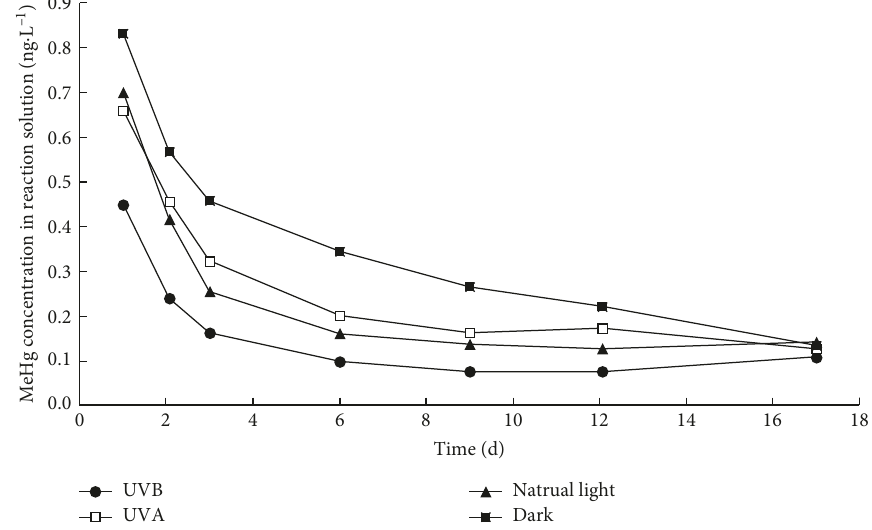
Figure 1: MeHg concentration variation with time. Initial MeHg concentration was 1ng · Hg · L − 1 .